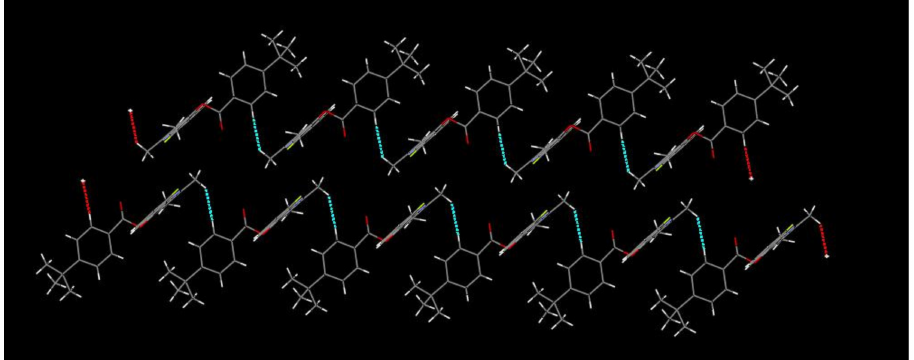
Figure 4. Chain structure of compound 2b